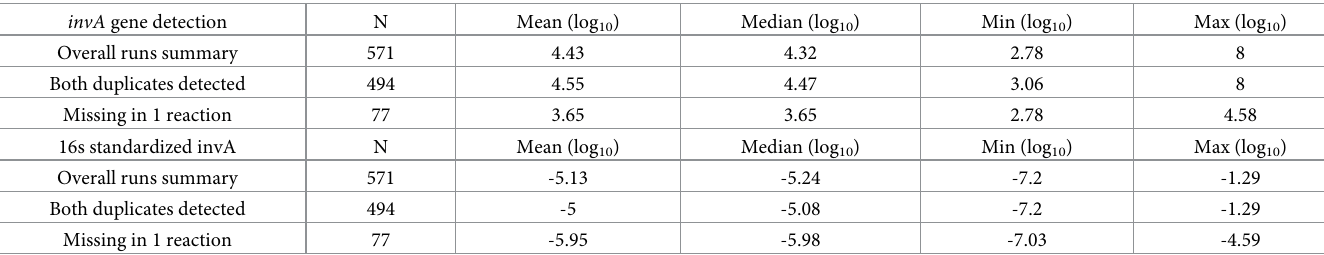
Table 3. Observed and 16s rRNA standardized log 10 invA gene copies per gram feces per qPCR reaction. invA gene